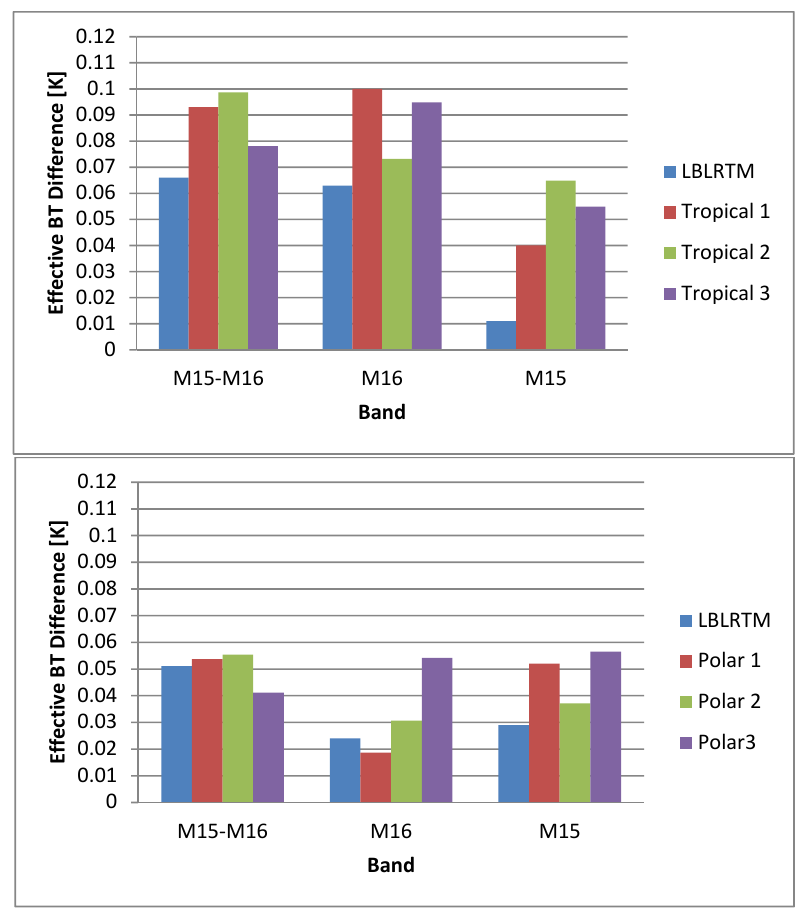
Figure 6. The magnitude of brightness temperature variation among 16 detectors for Visible Infrared Imaging Radiometer Suite (VIIRS) observation data and LBLRTM over tropical ( top ) and polar ( bottom ) region for six cases.